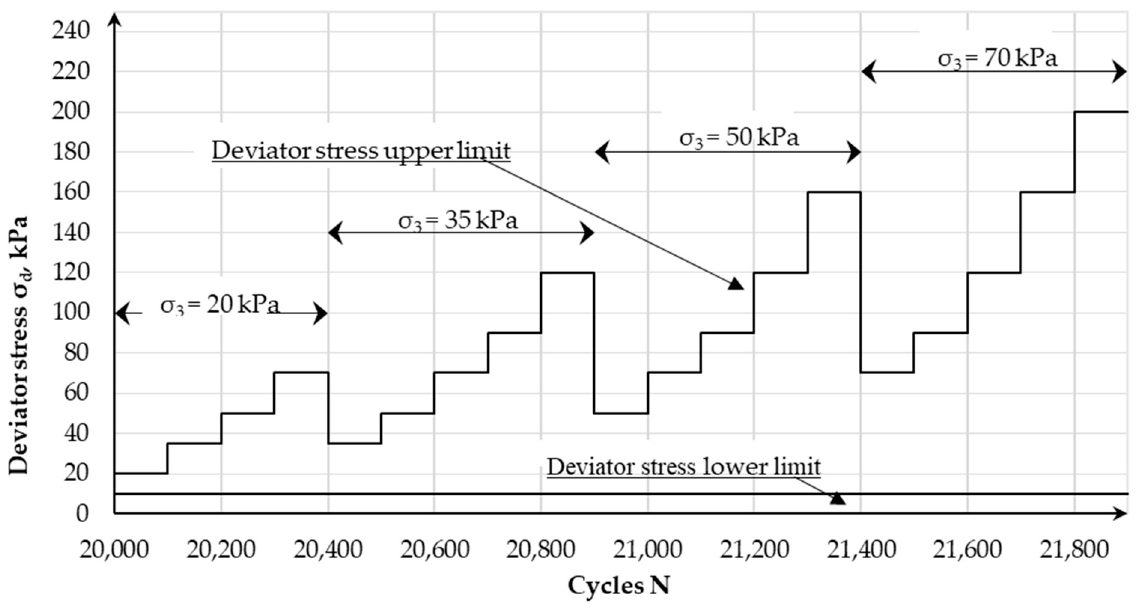
Figure 1. Test program—stress levels for the determinations of resilient behavior of soil specimens.